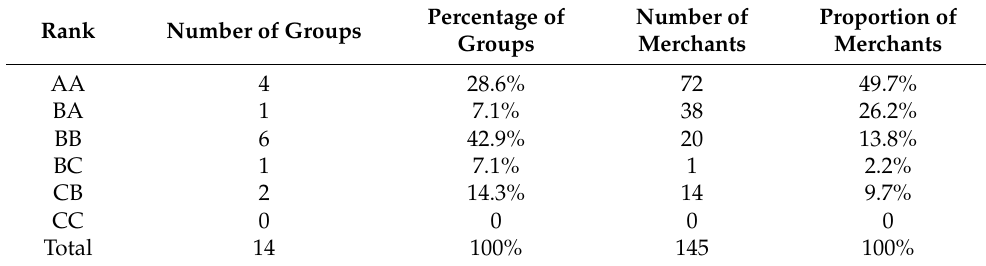
Table 8. The rank distribution of the groups hit by the model.